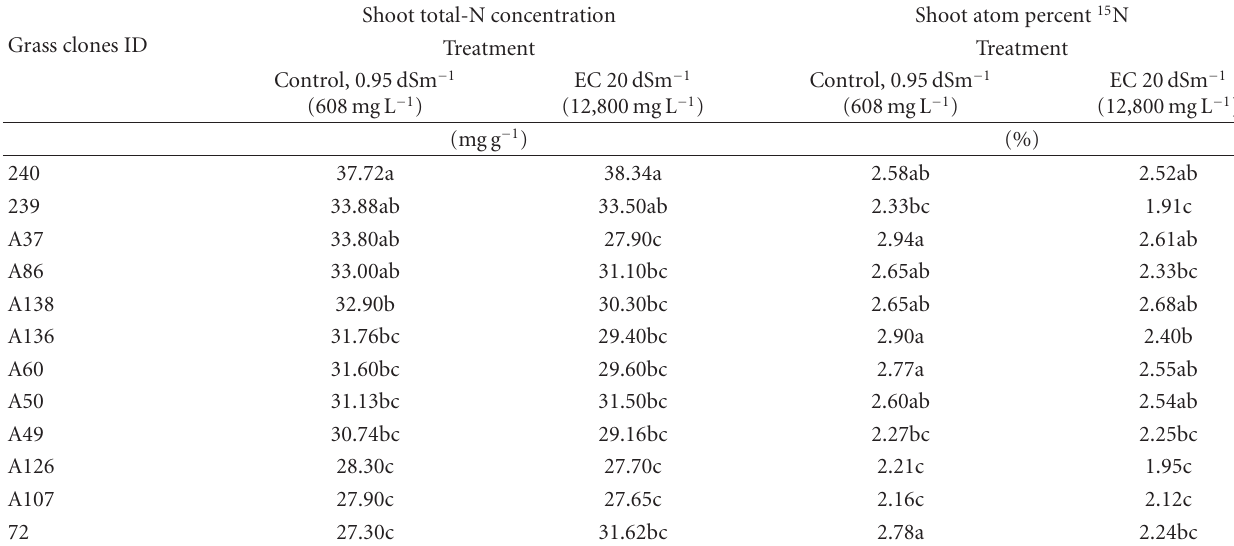
Table 4: Total nitrogen concentration (mgg − 1 ) and atom percent 15 N of various clones of saltgrass shoot tissues under the control and salt (NaCl) stress